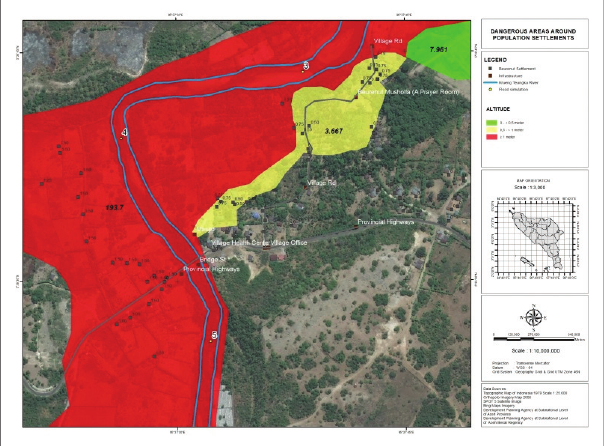
TABLE 3: The statistical result of the data. Description